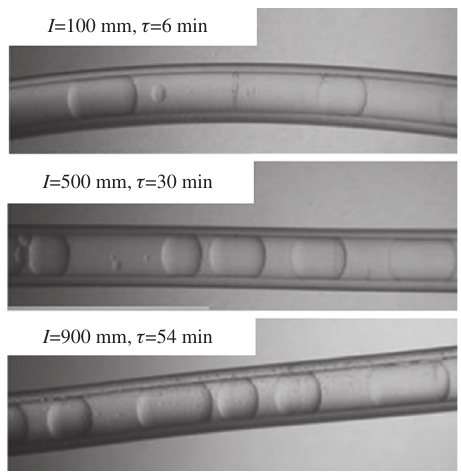
Figure 5 Slug flow behaviour of a two-phase system at various dis- tances ( l ) from the beginning of a FEP hold-up section and thereby at various residence times ( τ ) of a continuous [C